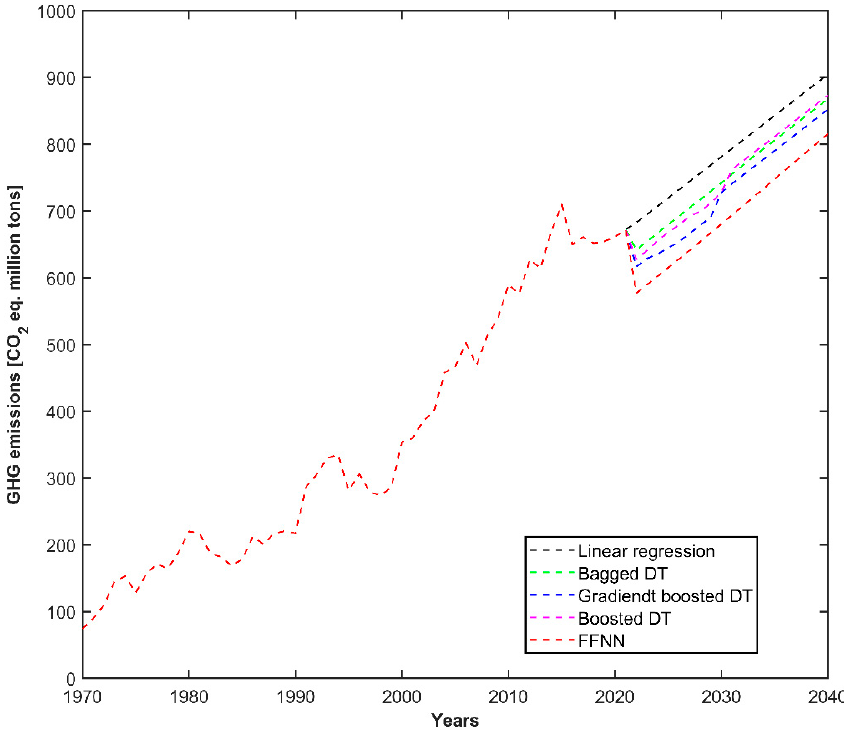
Table 3. DT-based AI model projected GHG emissions in 2040 for Saudi Arabia.